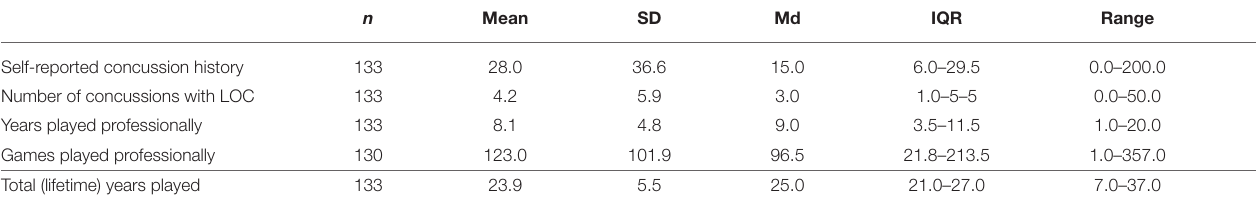
TABLE 1 | Self-reported exposure history.